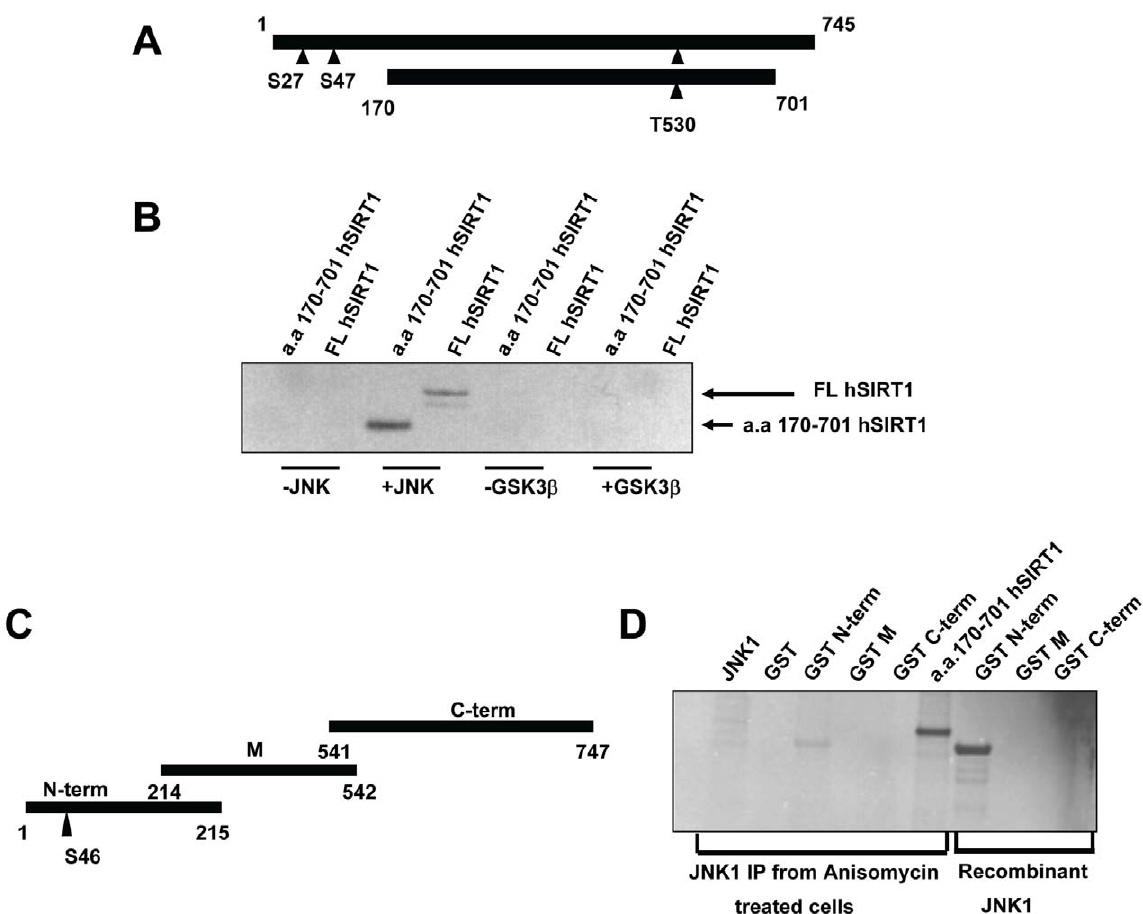
Figure 4. SIRT1 is phosphorylated by JNK1. A , Schematic representation of full length human SIRT1 (FL hSIRT1) protein and a truncated form (aa 170–701 hSIRT1). Triangles show putative JNK1 phosphorylation sites. B , phosphorylation of SIRT1 by recombinant JNK1. FL hSIRT1 or a.a. 170–701 hSIRT1 was incubated with recombinant JNK1 or GSK3 b in the presence of c -[ 32 P]-ATP. C , Schematic representation of mouse SIRT1 GST fragments. Triangle represents the putative JNK phosphorylation site. D, In vitro phosphorylation of mouse SIRT1 GST when treated with JNK1 immunoprecipitates from anisomycin-treated C2C12 cells or recombinant JNK1. Truncated hSIRT1 (a.a. 170–701 hSIRT1) was used as positive control.